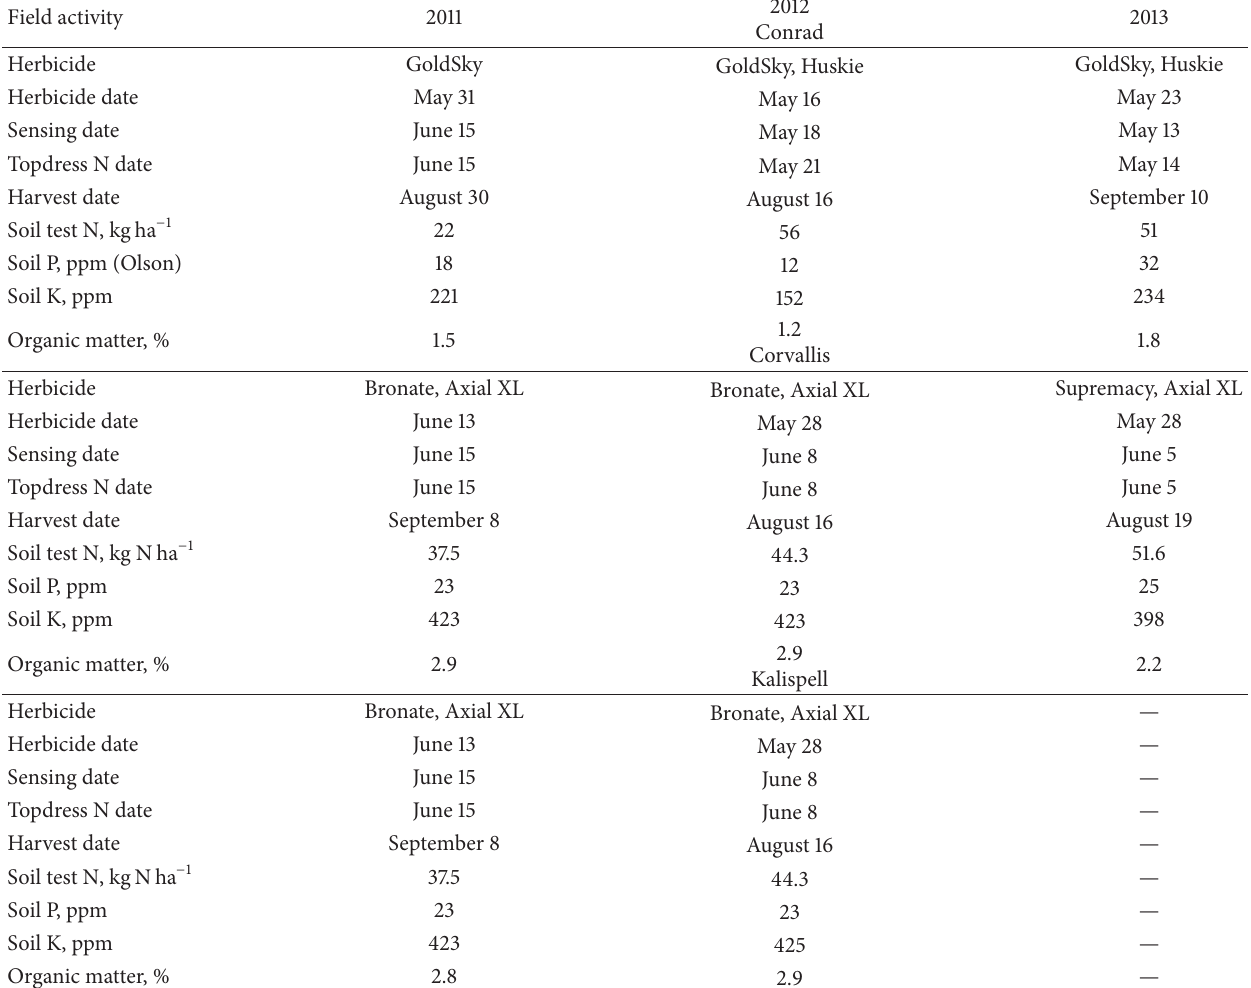
Table 1: Initial soil chemical properties (0–30 cm), growing conditions, and summary of field activities at Conrad, Corvallis, and Kalispell, MT, in 2011–2013.